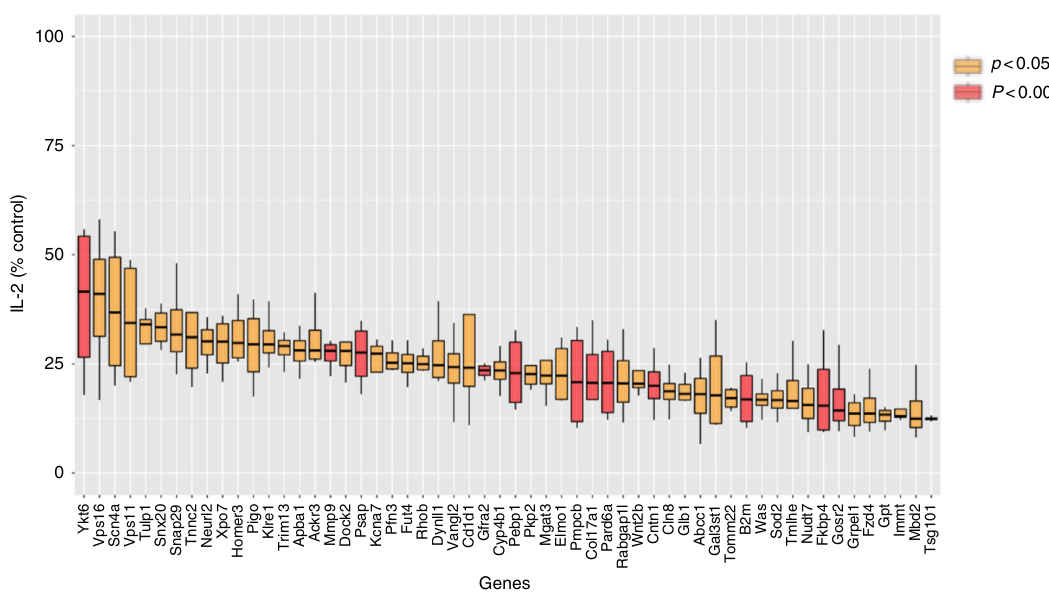
Fig. 2 Decreased lipid antigen presentation after knockdown of identi fi ed genes. J774-CD1d cells were transfected with siRNA pools, 36 h later these cells were loaded with GalGalCer for 6 h before culture with an iNKT cell hybridoma. Sixteen hours later supernatant was used to perform IL-2 Alpahlisa. Plot of normalized IL-2 release for selected hits compared to control. An average of three experiments is shown. Boxes represent the interquartile range; maximum and minimum values are displayed with vertical lines. p -Values are indicated (paired t